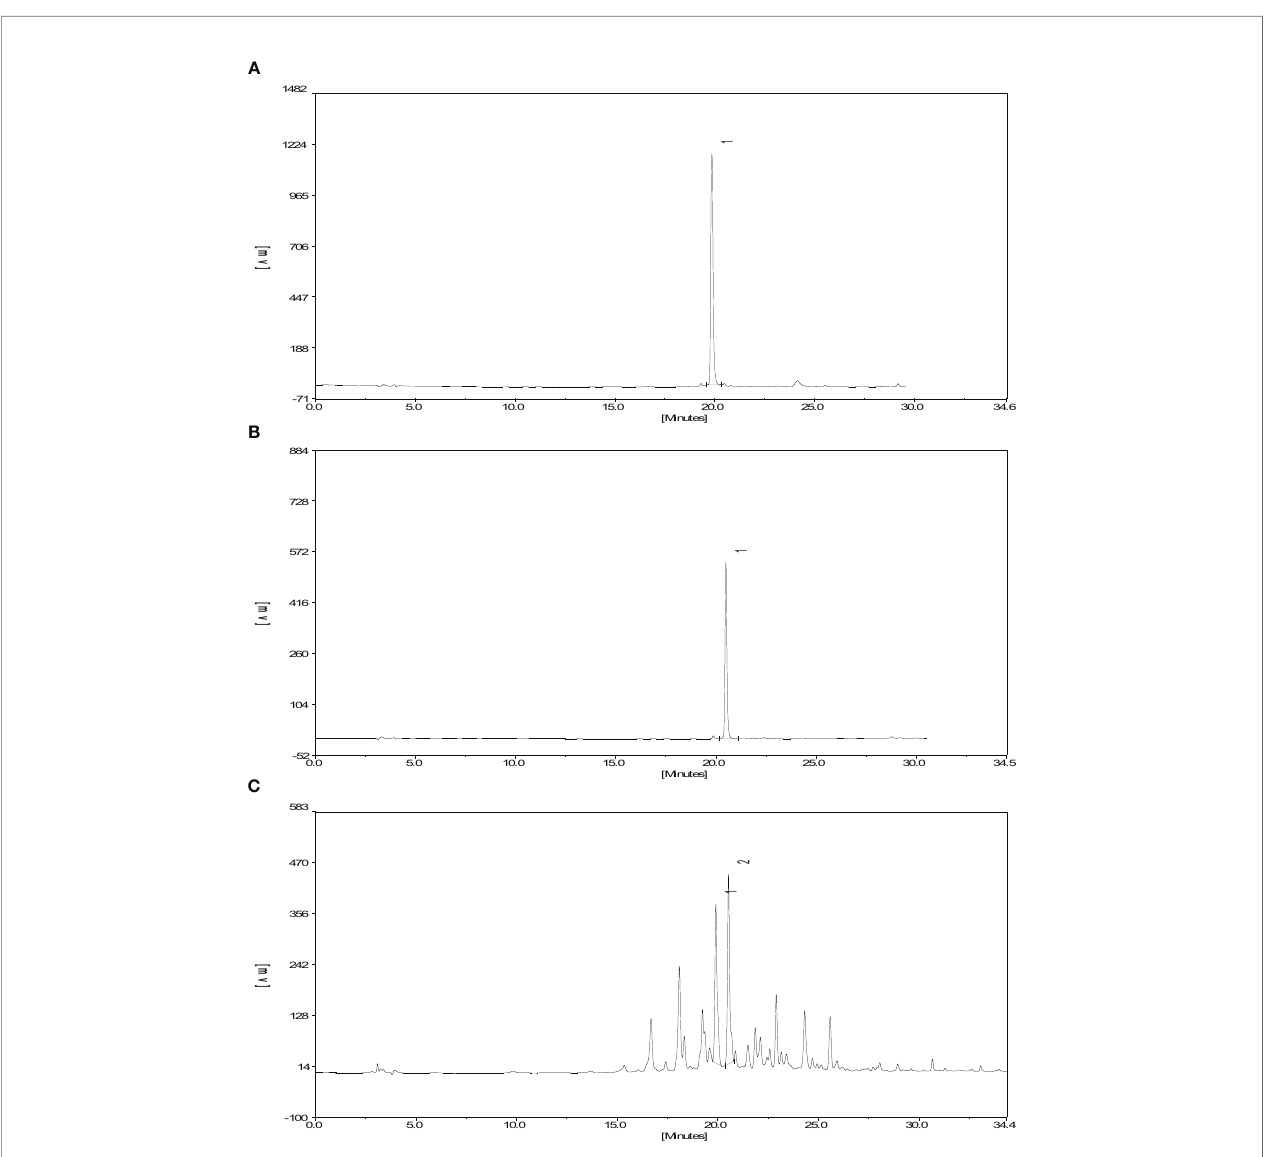
FIGURE 1 | High Performance Liquid Chromatography of PCFF. (A) complanatosides B reference substance; (B) complanatosides A reference substance; (C)